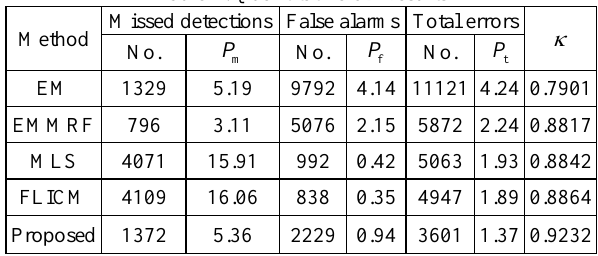
Table 1. Quantitative CD results Missed detections False alarms Total Method